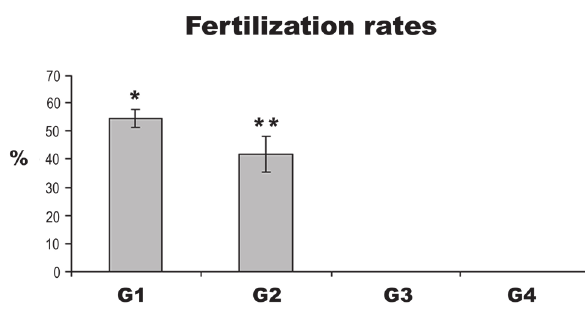
Table 2. Data on water quality during the period of artificial reproduction at Ponte Nova Fish Farm. Data are presented as the mean ± standard error of the mean. Fig. 1. Fertilization rates of Salminus hilarii for G1 (wild broodstock), G2 (domesticated broodstock), G3 (wild females, manually stripped) and G4 (domesticated females, manually stripped) at the Ponte Nova Fish Farm. Values (mean ± standard error of the mean) followed by different symbol are significantly different between experimental